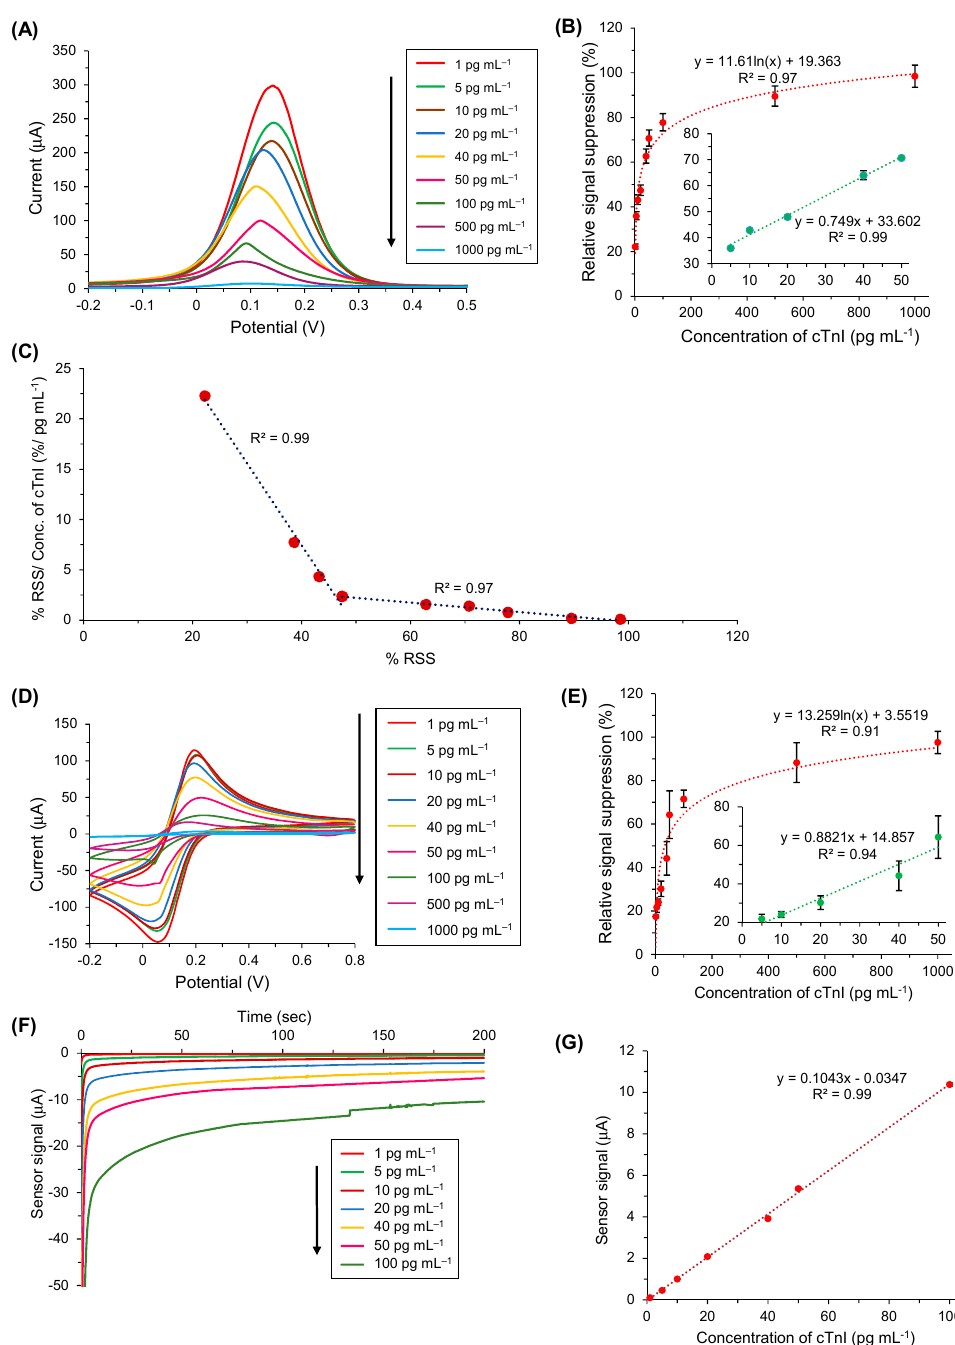
Figure 7. ( A ) Square-wave voltammograms of target binding with nine different cTnI concentrations (1–1000 pg mL − 1 ) in PBS. ( B ) Overall results of concentration-dependent cTnI bio-assay using SWV ( n = 3). The inset: linear regression for five concentrations of cTnI (5–50 pg mL − 1 ). ( C ) Scatchard plot showing a bilinear regime with K d values of 0.05 pM for concentrations below 40 pg mL − 1 of cTnI and 0.89 pM for all other concentrations exceeding 40 pg mL − 1 of cTnI. (D ) Cyclic voltammograms of target binding with nine different cTnI concentrations (1–1000 pg mL − 1 ) in PBS. ( E ) Overall results of concentration-dependent cTnI bio-assay using CV ( n = 3). The inset: linear regression for five concentrations of cTnI (5–50 pg mL − 1 ). ( F ) Real-time amperometric measurements were recorded for seven different concentrations of cTnI (1–100 pg mL − 1 ) using 10 mM H 2 O 2 . ( G ) Overall amperometric results for cTnI binding in the concentration range of 1–100 pg mL − 1 in PBS ( n = 3). Using Equations (2) and (3), the sensitivity ( S ) and the limit of detection (LOD) were calculated, respectively as 6.81 µA cm − 2 pg mL − 1 and 0.1 pg mL − 1 , where m is the slope, A